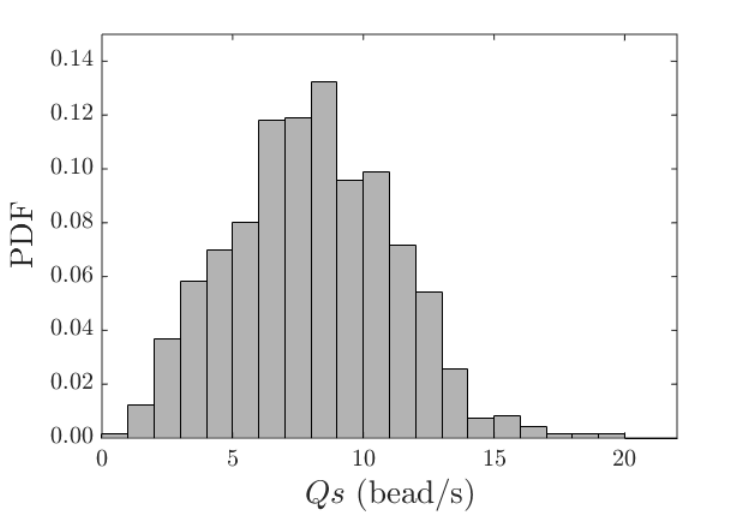
Figure 6. Normalized histogram of the bedload discharge, Q s , in particles per second, registered, in test T2, across the central 10 cm of the